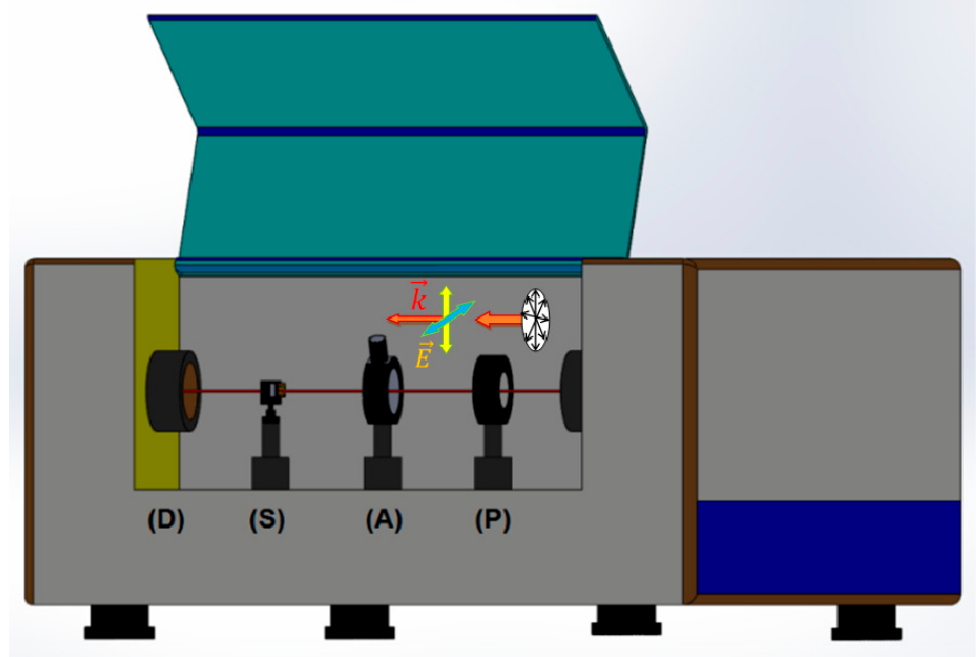
Figure 2. Transmission measurement setup with Fourier transform infrared spectrometer. Unpolarized incident infrared light (right side) passed through polarizer ( P ), aperture ( A ) and then exposed to nanostrip sample ( S ) before entering the detector ( D ). In case of nanodisk sample, polarizer ( P ) was removed and unpolarized infrared light was